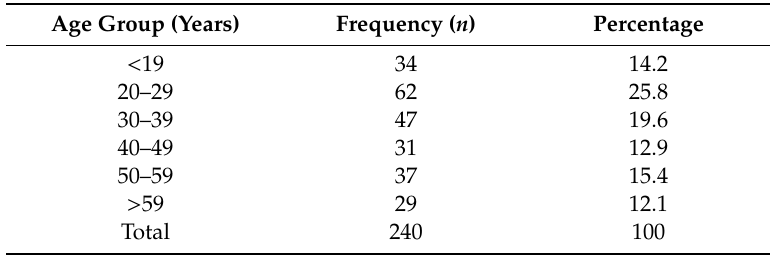
Table 5. Number of respondents for each age group of the